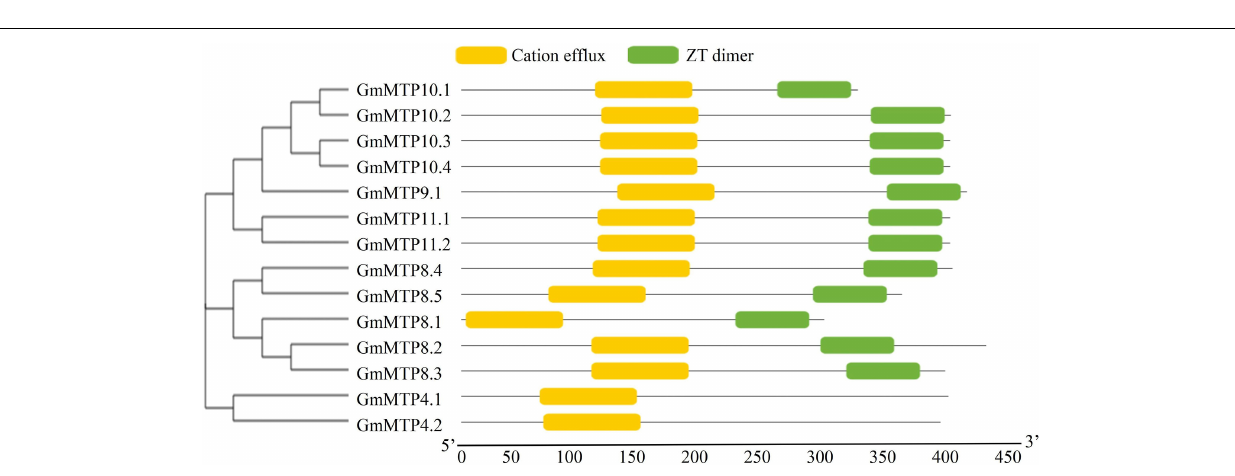
and GmMTP4.2 were classified into group 1 within the